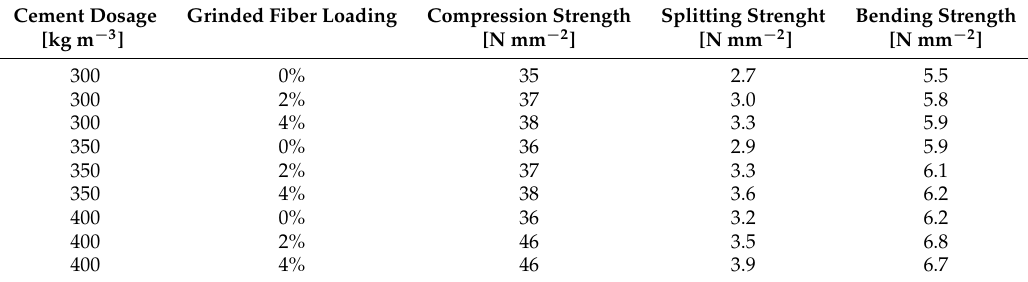
Table 4. Selected mechanical properties of Miscanthus concrete specimens by Acikel et al.